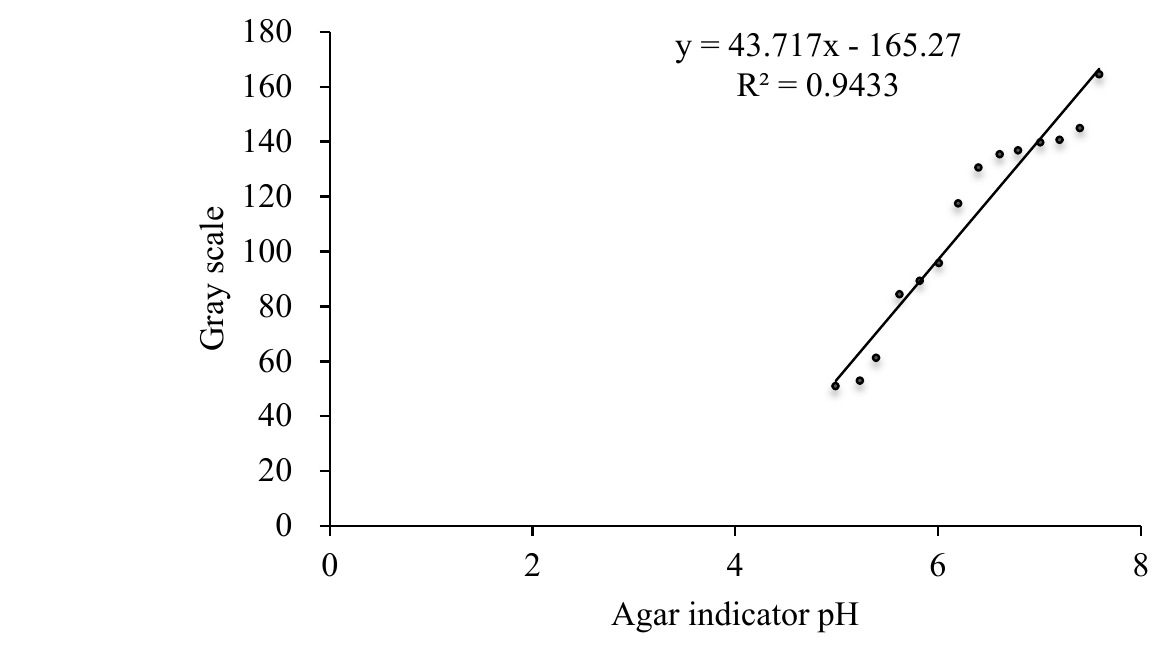
Figure 8. Calibration curve between the gray level of color and pH in P. vittata . Table 6. Effects of Ce colonization on the pH and amount of protons secreted in the P. vittata rhizo- sphere .